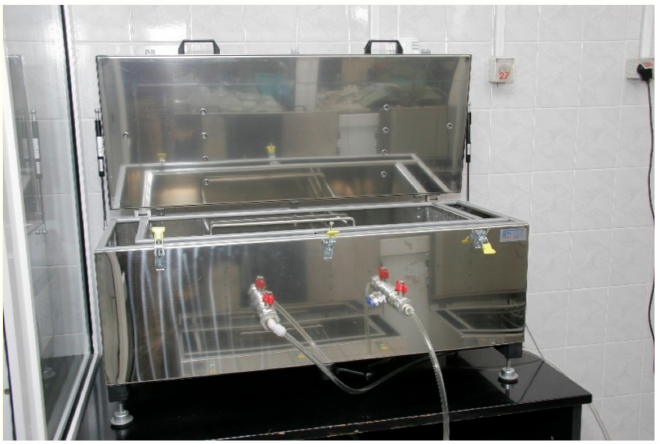
Figure 2. Testing